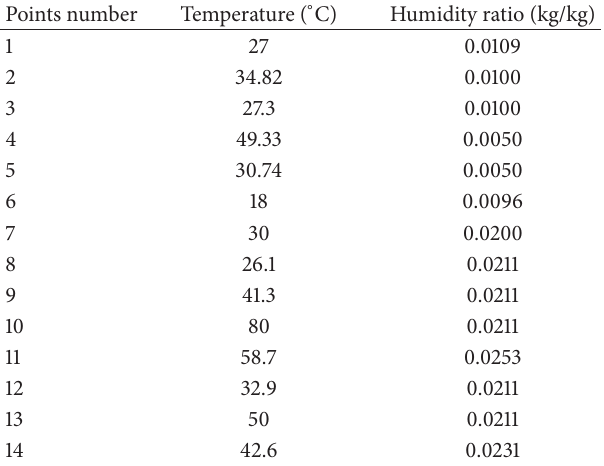
Table 6: Air properties of two-stage solar desiccant cooling system in recirculation